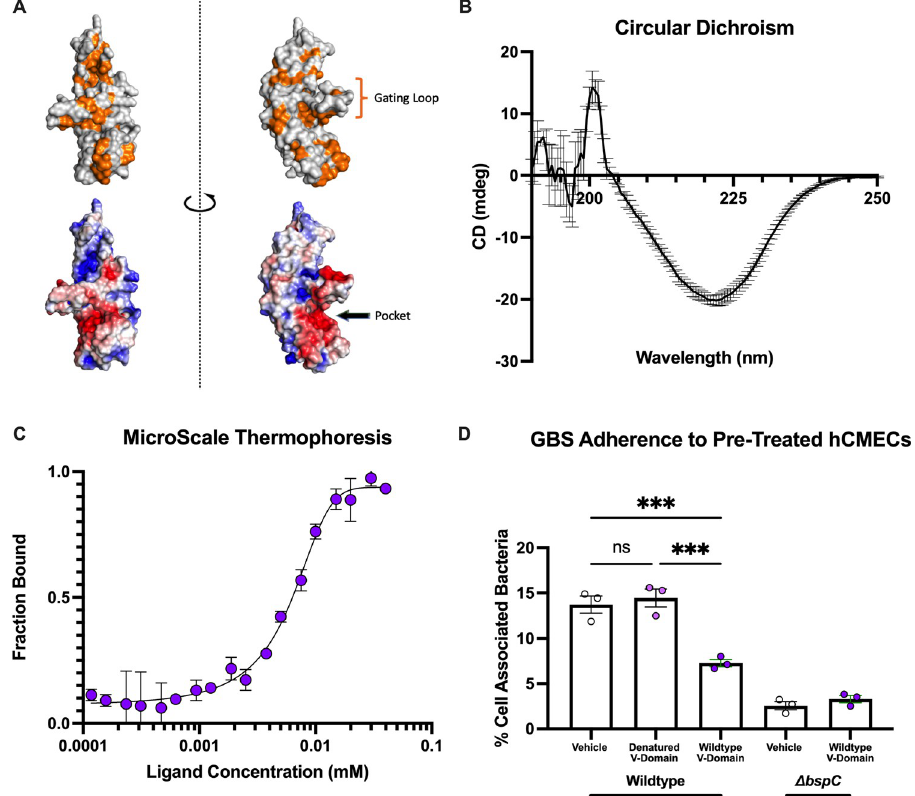
Fig 2. Mapping vimentin binding activity to the BspC V-domain. (A) The V-domain of BspC was modeled using BspA as a template. Surface residues are shown with hydrophobic residues colored in orange (top) and electrostatic potential as calculated by APBS (bottom) colored with red indicating higher potential and blue indicating lower potential. APBS calculation and visualization were performed using PyMOL. (B) Circular dichroism spectrum of a 1 mg/mL solution of the BspC V-domain. (C) The V-domain was added to 20 nM vimentin at the indicated concentrations prior to measuring the microscale thermophoresis dose response curve quantifying the dissociation constant. (D) hCMECs were pretreated with PBS (vehicle), the V-domain added to a concentration of 10 μ M, or 10 μ M of denatured V-domain 30 minutes prior to infection. CFU were plated and to assess V-domain blocking of GBS adherence after 30 minutes of incubation. B-D display means from 3 independent experiments. Error bars indicate standard error of the mean. Statistical analysis: (D) One-way ANOVA with Tukey’s multiple comparisons. ��� , P <